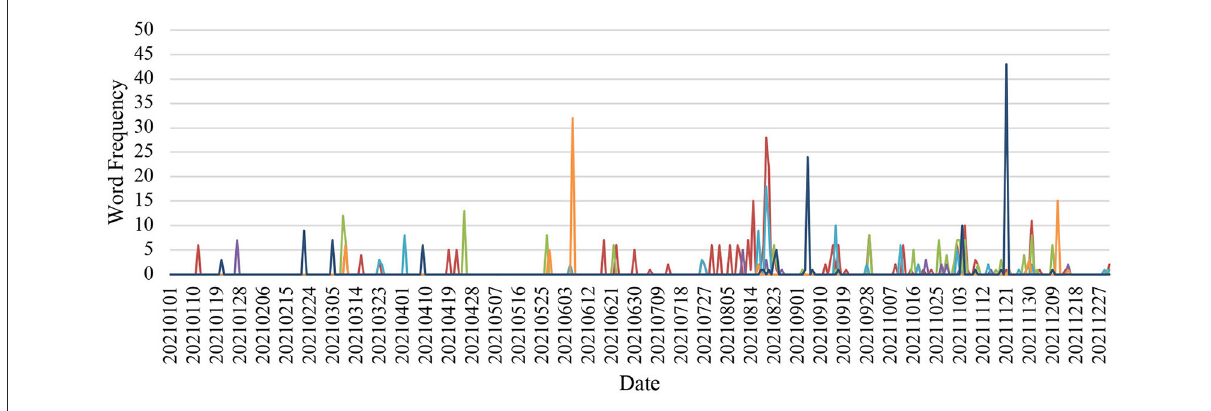
FIGURE4 Lombarda China Healthcare Mix Fund.